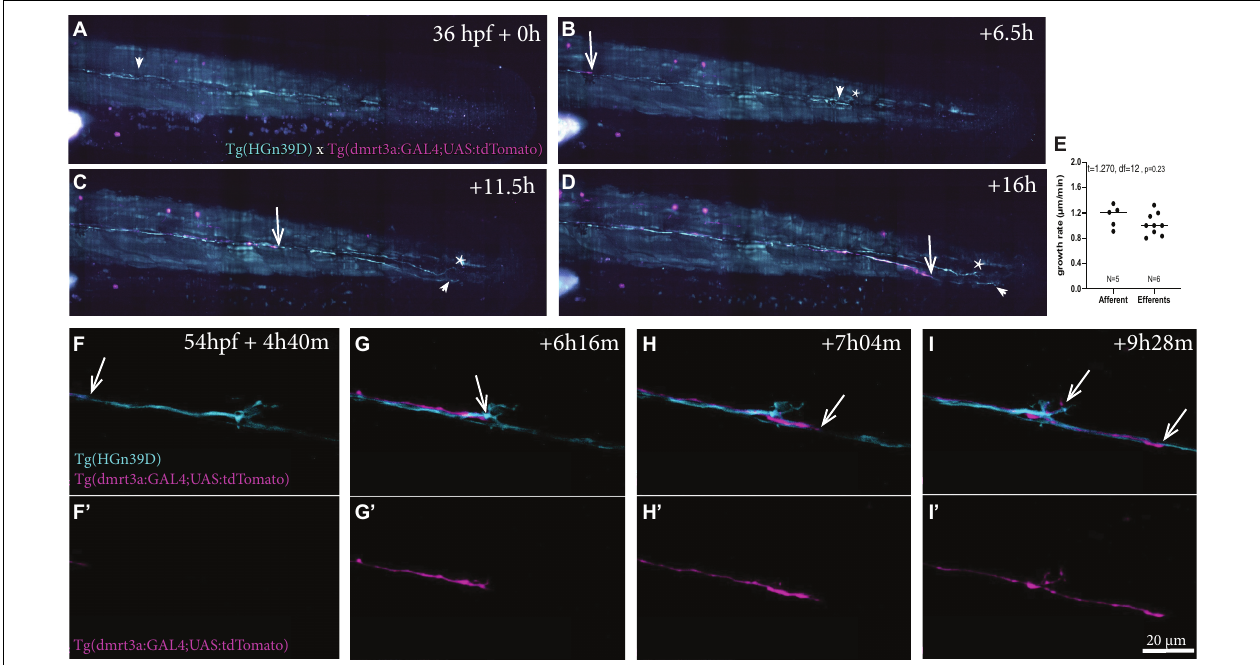
FIGURE 5 | Time-lapse recordings of sensory afferent and inhibitory efferent processes growing along the PLL. (A–D) Time frames of time-lapse imaging made by digital light-sheet microscopy in a Tg(HGn39D; dmrt3a :GAL4;UAS:tdTomato) larva. Arrowheads indicate the growth cone for the sensory afferent projection and arrows indicate the growth cone of the inhibitory efferent projection. Asterisks indicates projections on the other side of the larvae’s body visible in the maximum intensity projections. (E) The growth rate between the sensory afferent projections (1.15 ± 0.18 µ m/min) and inhibitory efferent projections (1.0 ± 0.17 µ m/min) was not significantly different ( t = 1.581, df = 14, p = 0.14). (F–I) Higher magnification time-lapse confocal imaging of the synaptic terminals of afferent processes and a single inhibitory efferent process [ (F’–I’) show inhibitory efferent projection only]. Recordings show innervation of a neuromasts by sensory afferents prior to inhibitory efferent innervation. Arrows indicate the growth cone of the inhibitory efferent. Age of larva in (A) 36 hpf; Age of larva in (F) is 54 hpf.